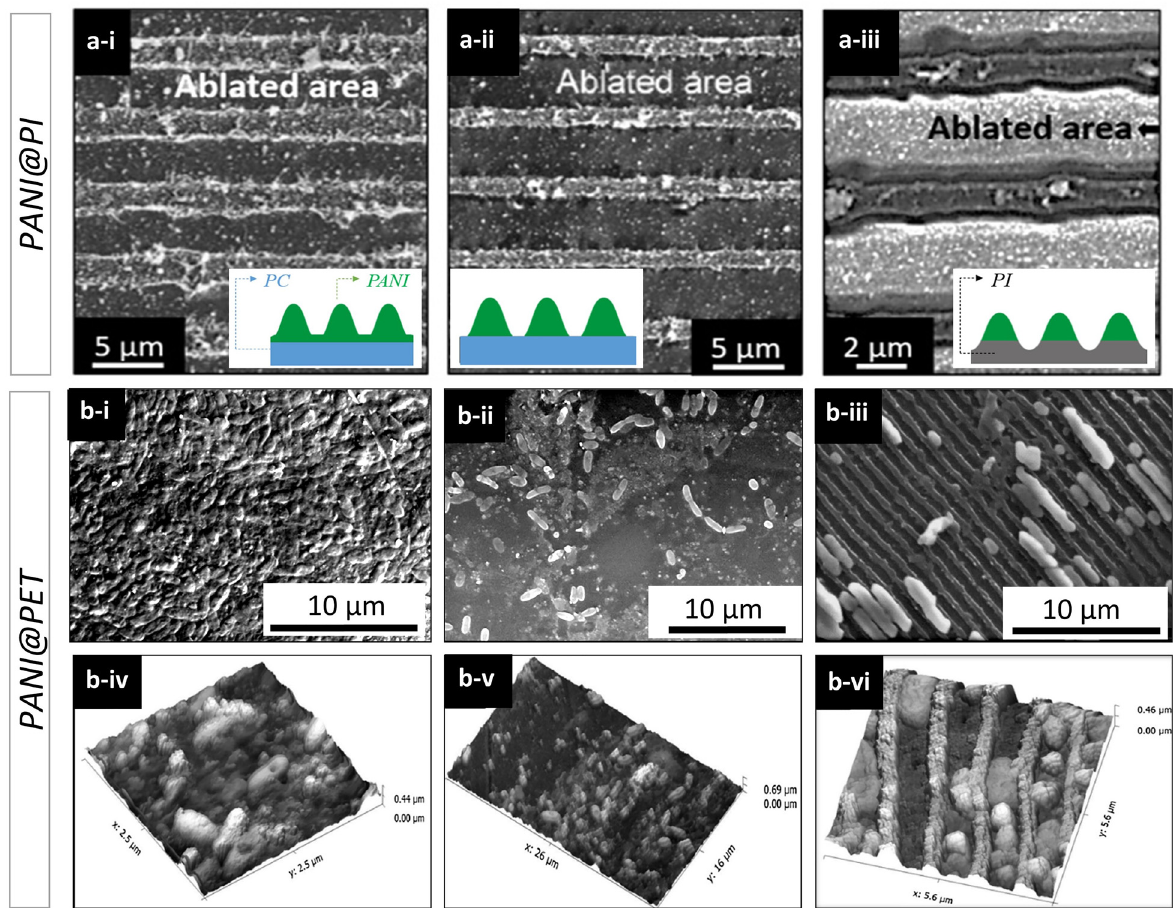
Figure11: (upperrow)SEMimagesofPANI@PCnanostructuressupportedat(a-i)laserfluence325mJcm − 2 ;(a-ii)laser fl uence174mJcm − 2 and (a-iii) PANI@PI laser fl uence 194 mJ cm − 2 where the substrate is also ablated. The scheme bottom right the diagram indicates the type of material ablated; (middle and lower rows) SEM micrographs of the bio fi lm formed (grown for 24 h) on (b-i) PET, (b-ii) PANI@PET fi lm and (b-iii) PET-PANI structured by DLIP and AFM micrographs of the bacteria grown for 24 h on (b-iv) PET, (b-v) PANI@PET and (b-vi) PANI@PET-DLIP. Figures adapted from ref. [116] (© 2007 WILEY-VCH Verlag GmbH & Co. KGaA) and ref. [78] (© 2016 Elsevier